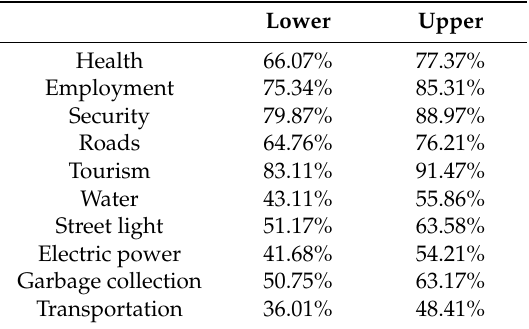
Table 3. Basic services, statistical inference.